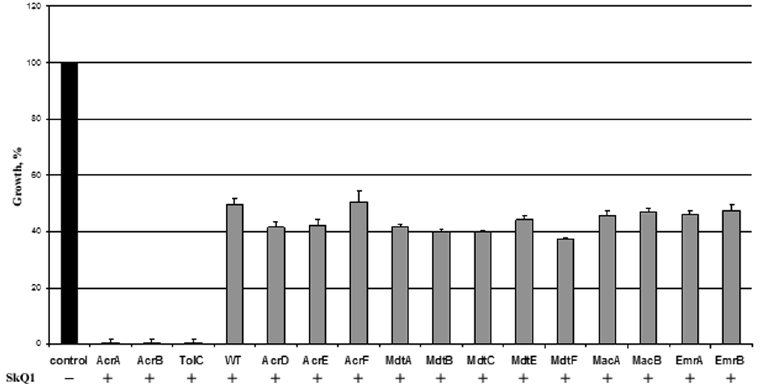
Figure 2. Growth of E. coli strains having deletions in various transporters in the presence of 10 μ M SkQ1. SkQ1 was added at “0” time to the LB medium. Growth was evaluated after 15–35 h incubation at 30 °C or 37 °C by absorbance at 620 nm. The growth of WT E. coli cells in the absence of SkQ1 is referred as a control. The data points represent mean ± SD of three